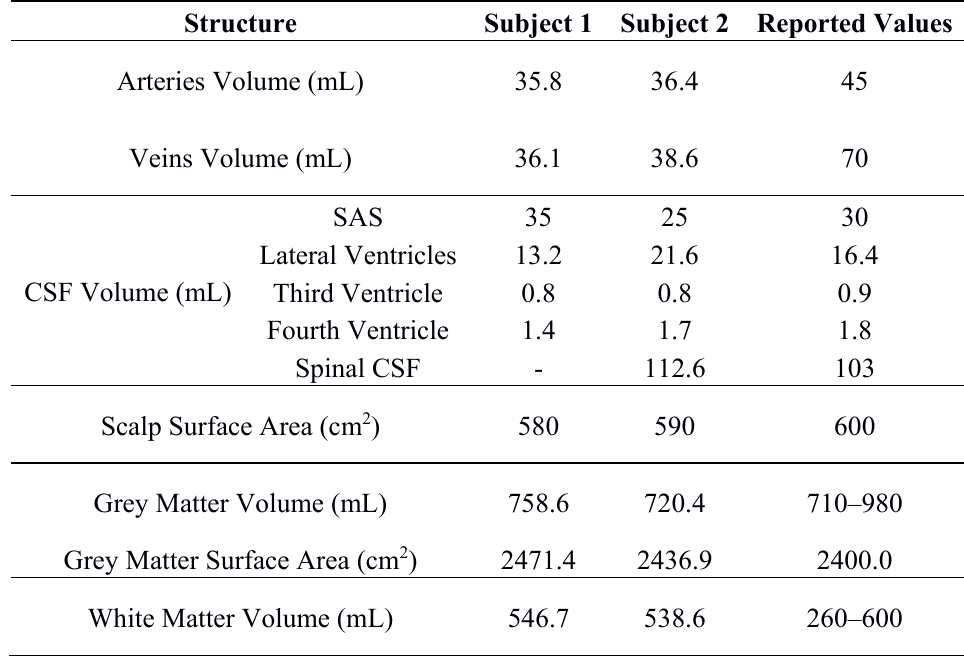
Table 1. Mesh properties of each individual structures for two